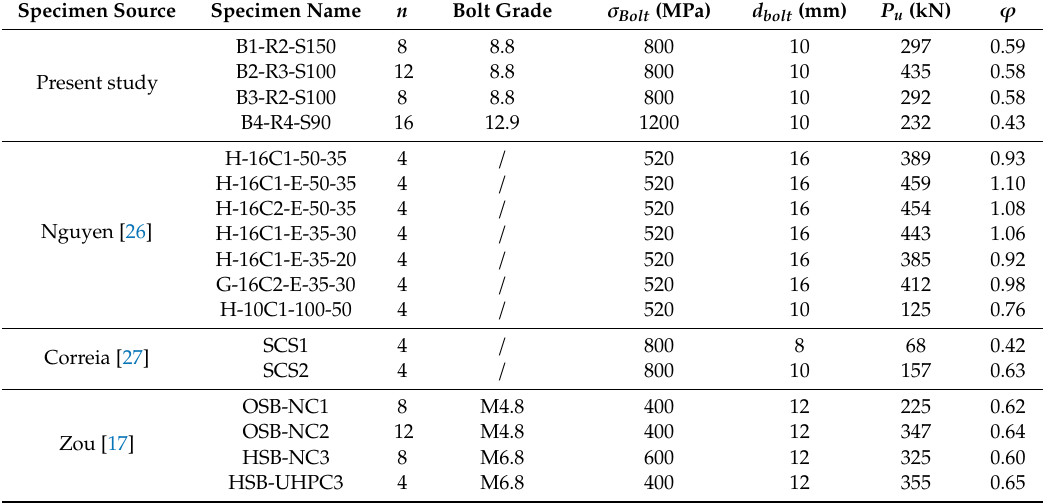
Table 4. Validation of predicted formula validity.